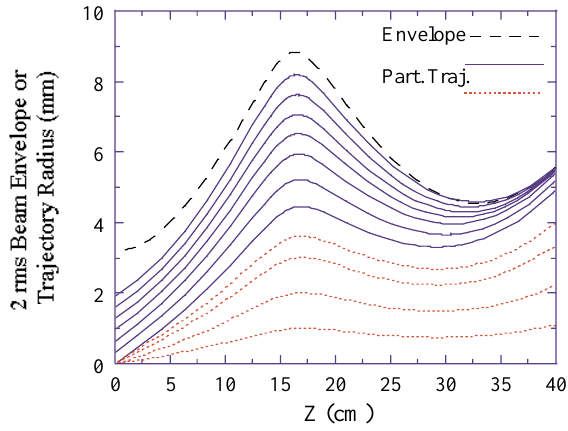
FIG. 6. (Color) KV trajectories: tracking of core particles with solenoid focusing in the gridded gun experiment. The solid lines correspond to trajectories with initial slopes equal to the maximum values consistent with the KV ellipse at z (cid:1) 0 1 (see inset in Fig. 5a). A uniform density profile at every z plane can be constructed if other trajectories (e.g., dotted lines) are included. These additional trajectories illustrate the existence of temperature in the